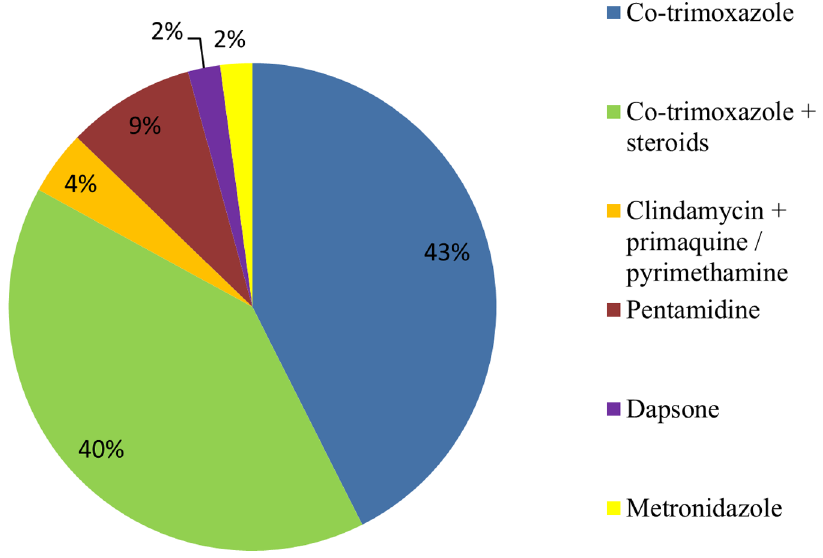
Figure 2. Treatment strategies for PCP in reviewed studies. Total strategies for this analysis=46. doi:10.1371/journal.pone.0069969.g002 PLOS ONE |